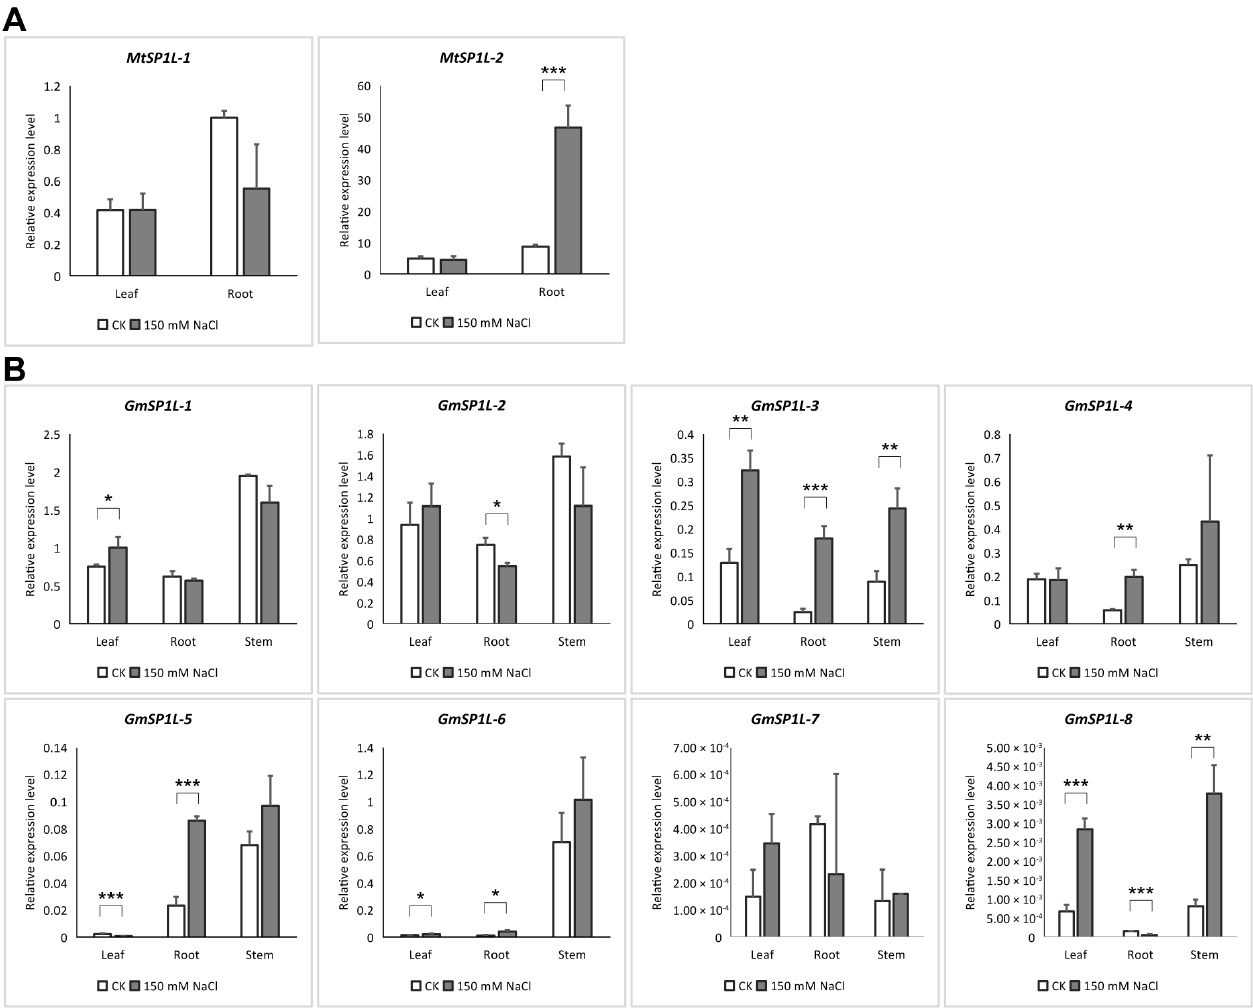
Figure 8. Effects of salt treatments on the SP1L s transcript levels in M. truncatula and G. max . The expression levels of the MtSP1Ls ( A ) and GmSP1Ls ( B ) genes under sodium chloride treatments. The asterisk indicates significant differences among mean values compared with the control group (Student’s t -test: *** p < 0.001, ** 0.001 < p < 0.01, and * 0.01 < p < 0.1). The results were based on three replicates in three independent experiments.